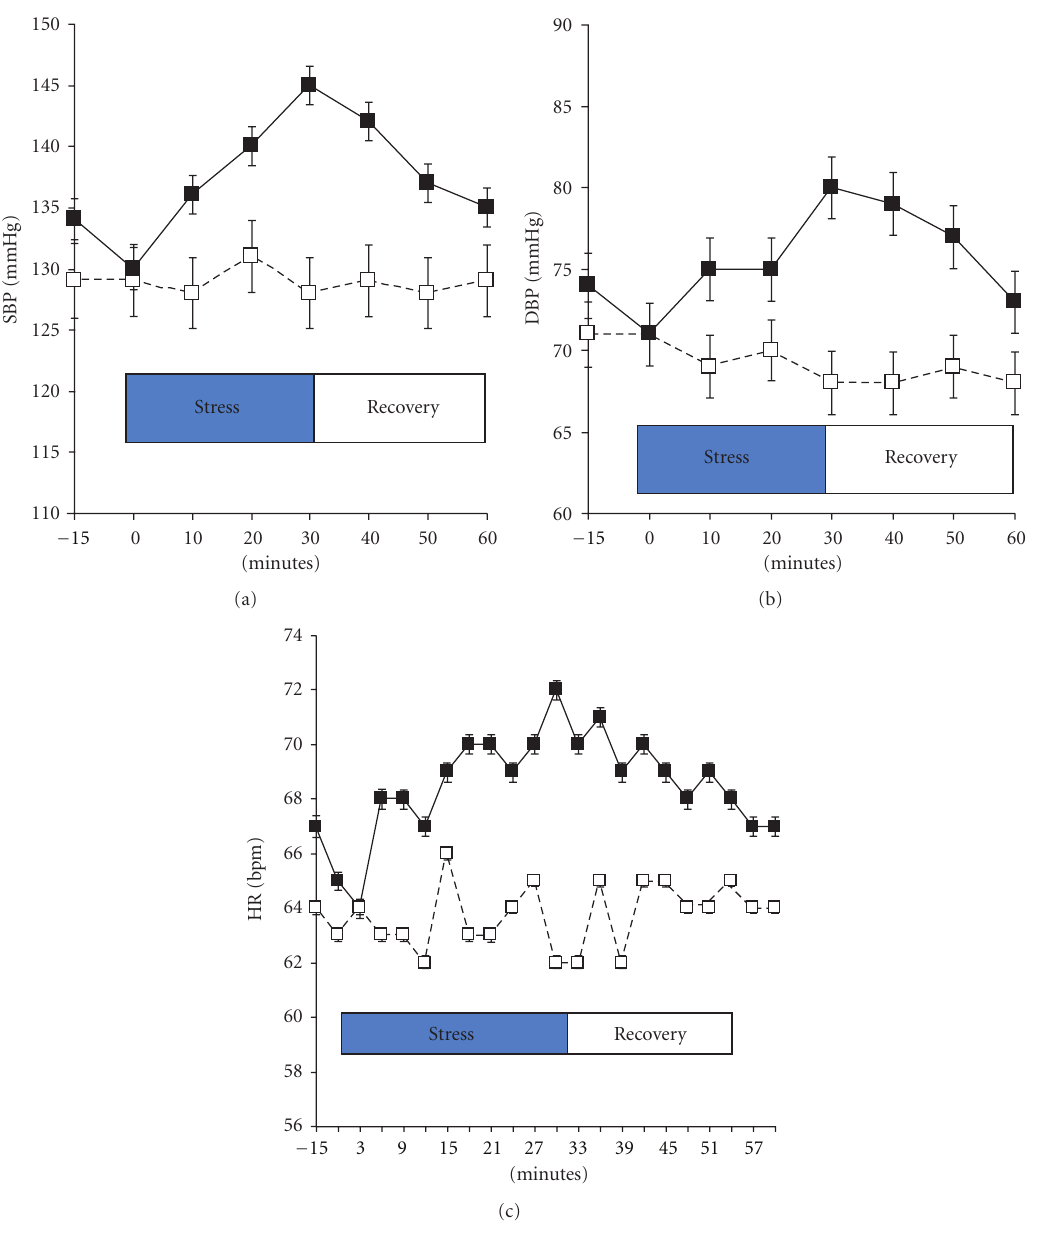
Figure 1: Di ff erences in (a) systolic and (b) diastolic blood pressure and (c) heart rate response during the stress challenge (solid line) and control (broken line) condition. Data are mean ± se; N =